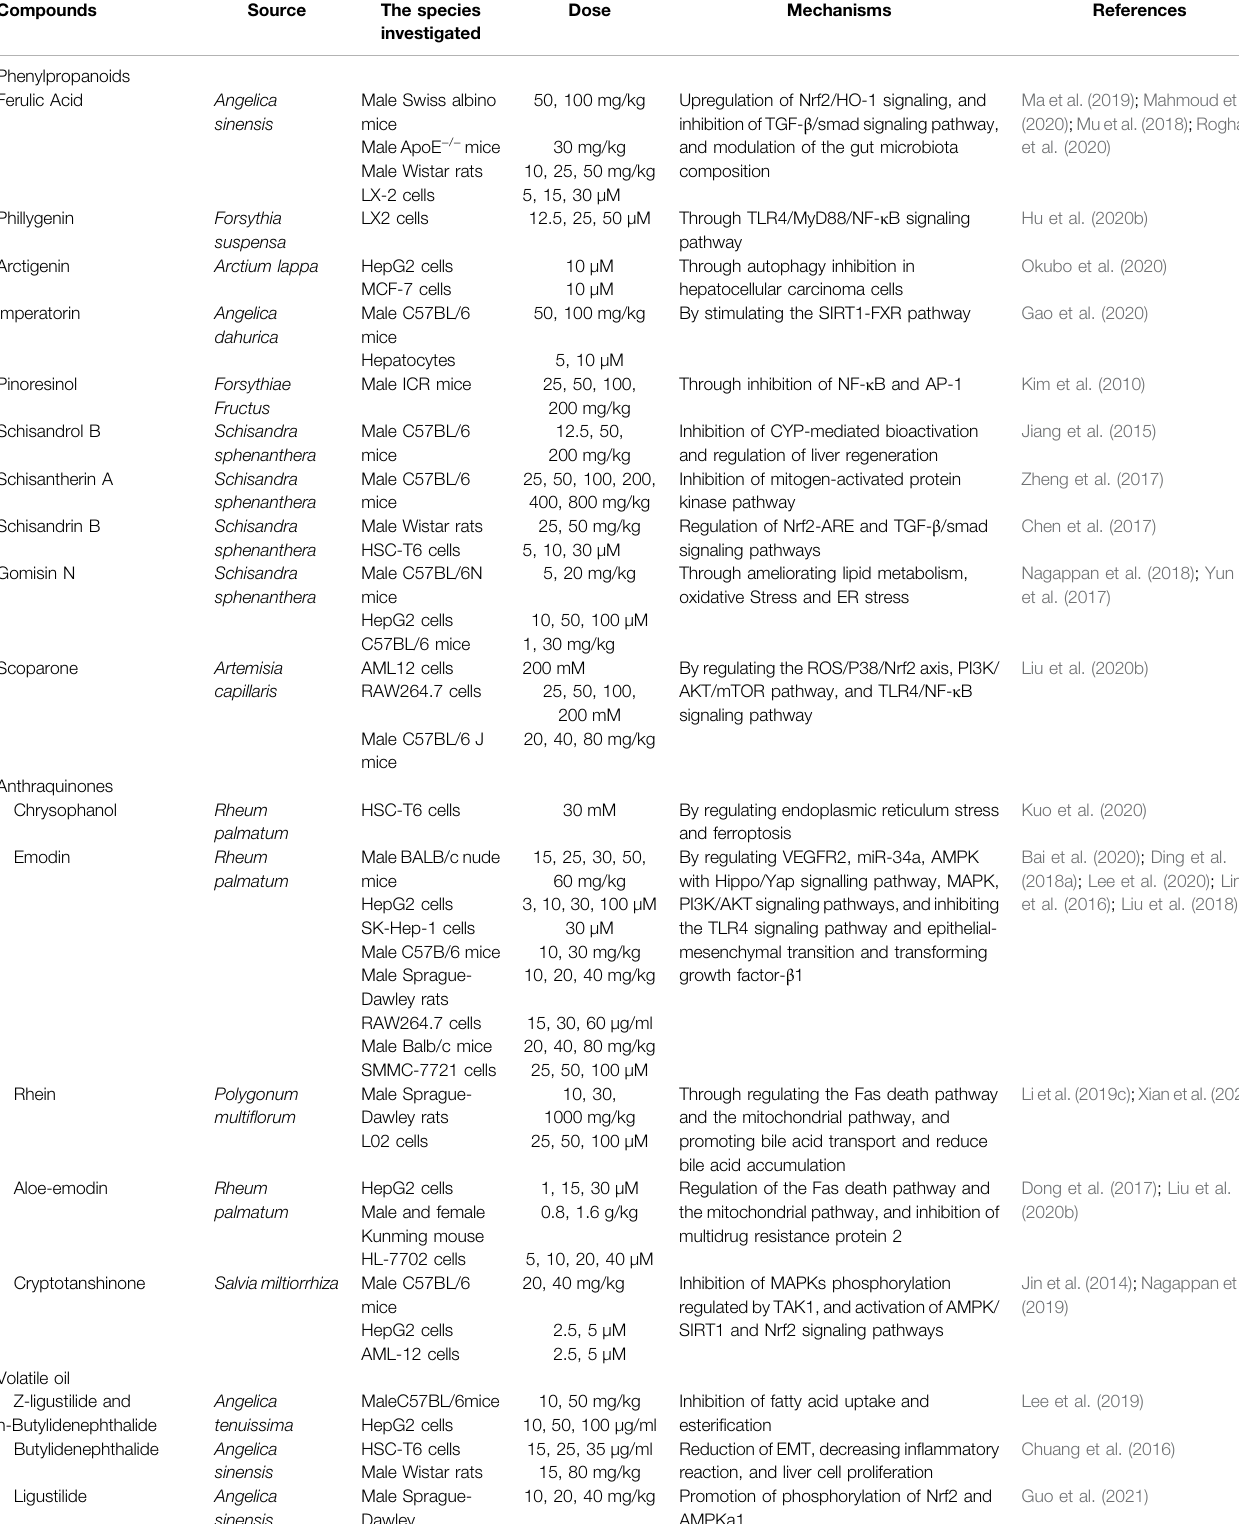
TABLE 6 | Summary of other bioactive ingredients with signi fi cant anti-liver disease activity.